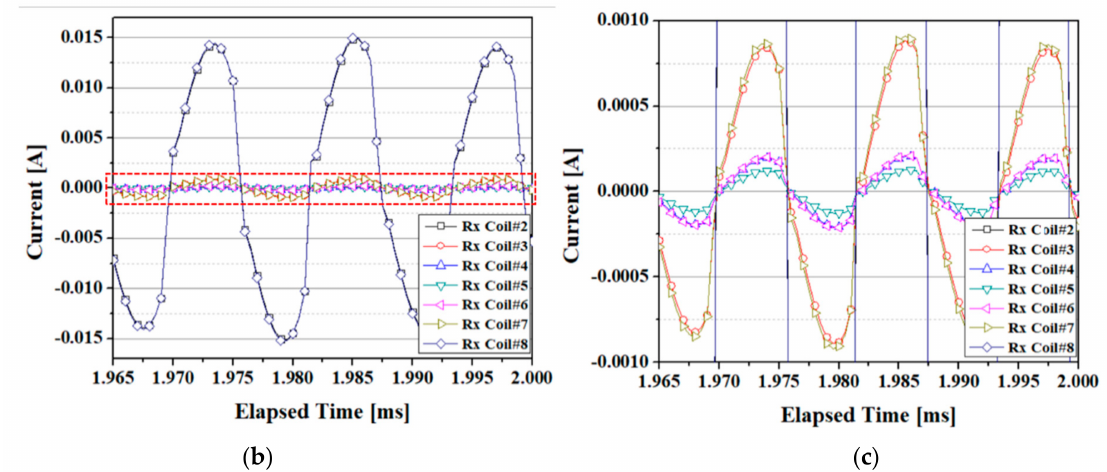
Figure 15. Simulation results: ( a ) transmitter coil current waveform and aligned receiver coil induced current waveform, ( b ) non-aligned receiver coil induced currents, and ( c ) zoom-in of red area in ( b